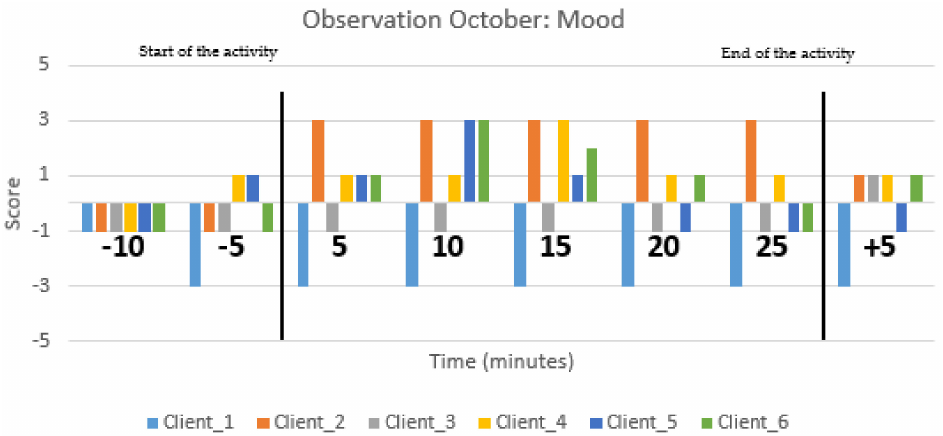
Figure 6. An observation score on mood during a group activity with the Zora robot in which six clients participated. All clients are from a psychogeriatric ward. Each colored bar represents one client. On the X-axis, the time prior to an activity ( − 10 and − 5), the time during the activity (0–25) and after the activity (+5) are given. On the Y-axis, the mood score ( − 5 to +5) is given. The black vertical lines mark the start and end of the group activity with